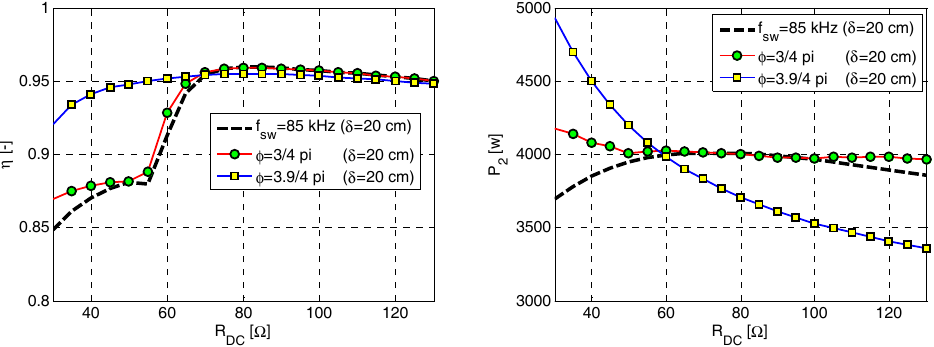
Figure 14. Efficiency ( left ) and power delivered to the load ( right ) during phase-shift control and fixed switching frequency operation—operational distance 20 cm.